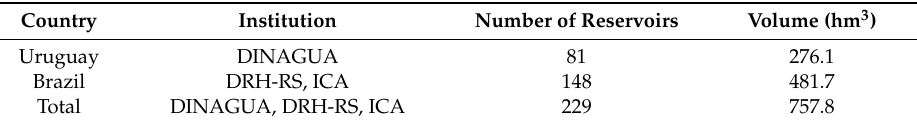
Table 2. Number and total demand for reservoirs in the Cuareim / Quara í